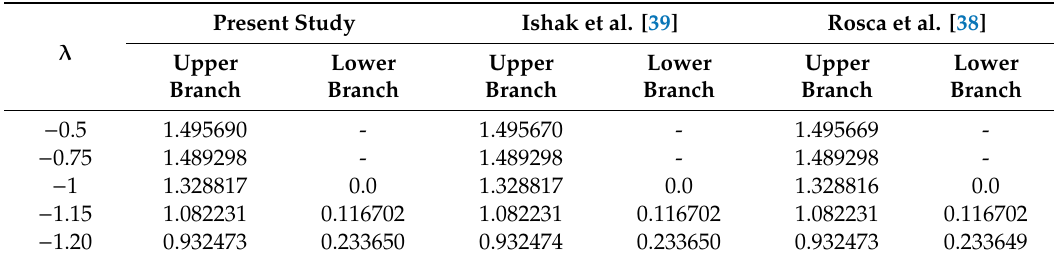
Table 1. Comparison of f (cid:48)(cid:48) ( 0 ) for M = 0 and λ < 0 (shrinking sheet). Present Study Ishak et al. [39] Rosca et al. [38] λ